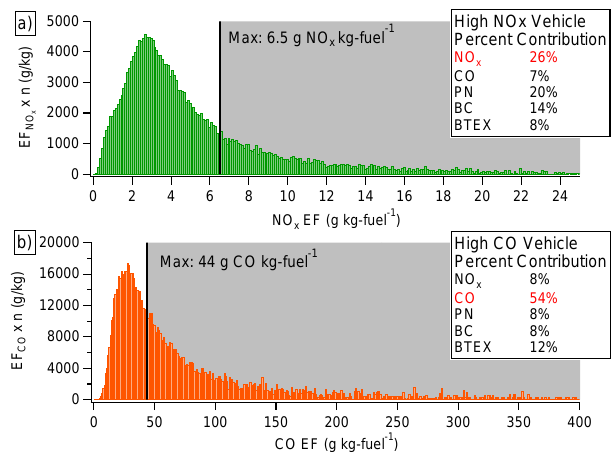
Figure 7. Product distribution histograms of NO x (a) and CO (b) EFs of captured plumes from the detectable fleet with the max- imum allowable emissions indicated by the black line. The plumes that exceed this limit (gray area) with corresponding percent contri- butions of other pollutants (text box). Not shown are 28 and 67% of BT EF plumes for NO x and CO,